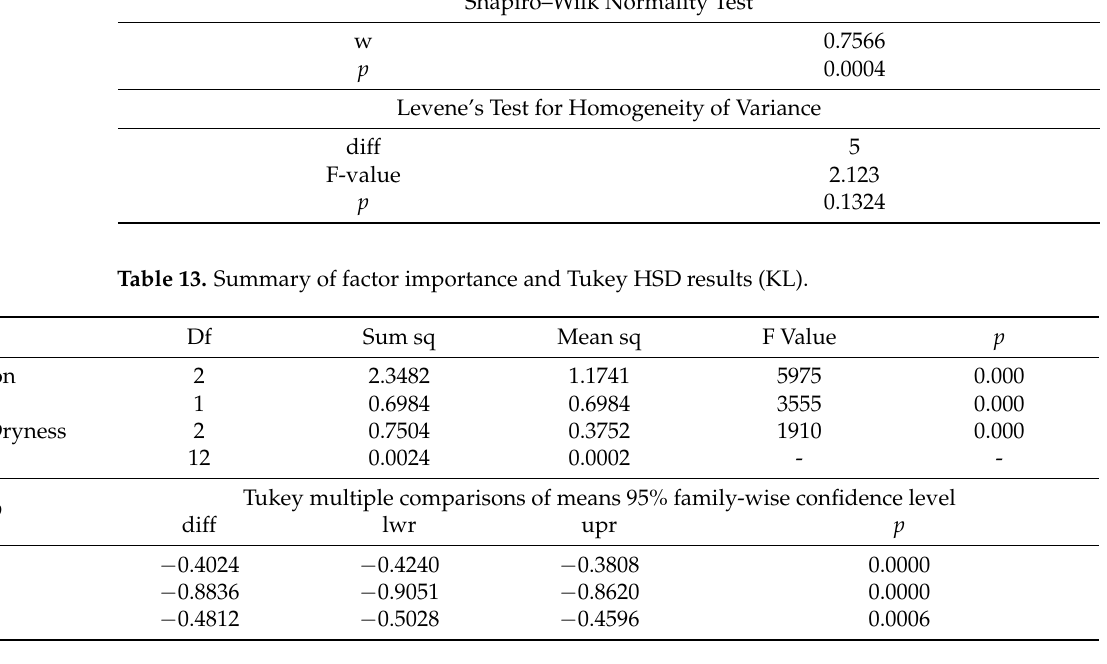
Table 14. Shapiro and Levene’s test result (PT).